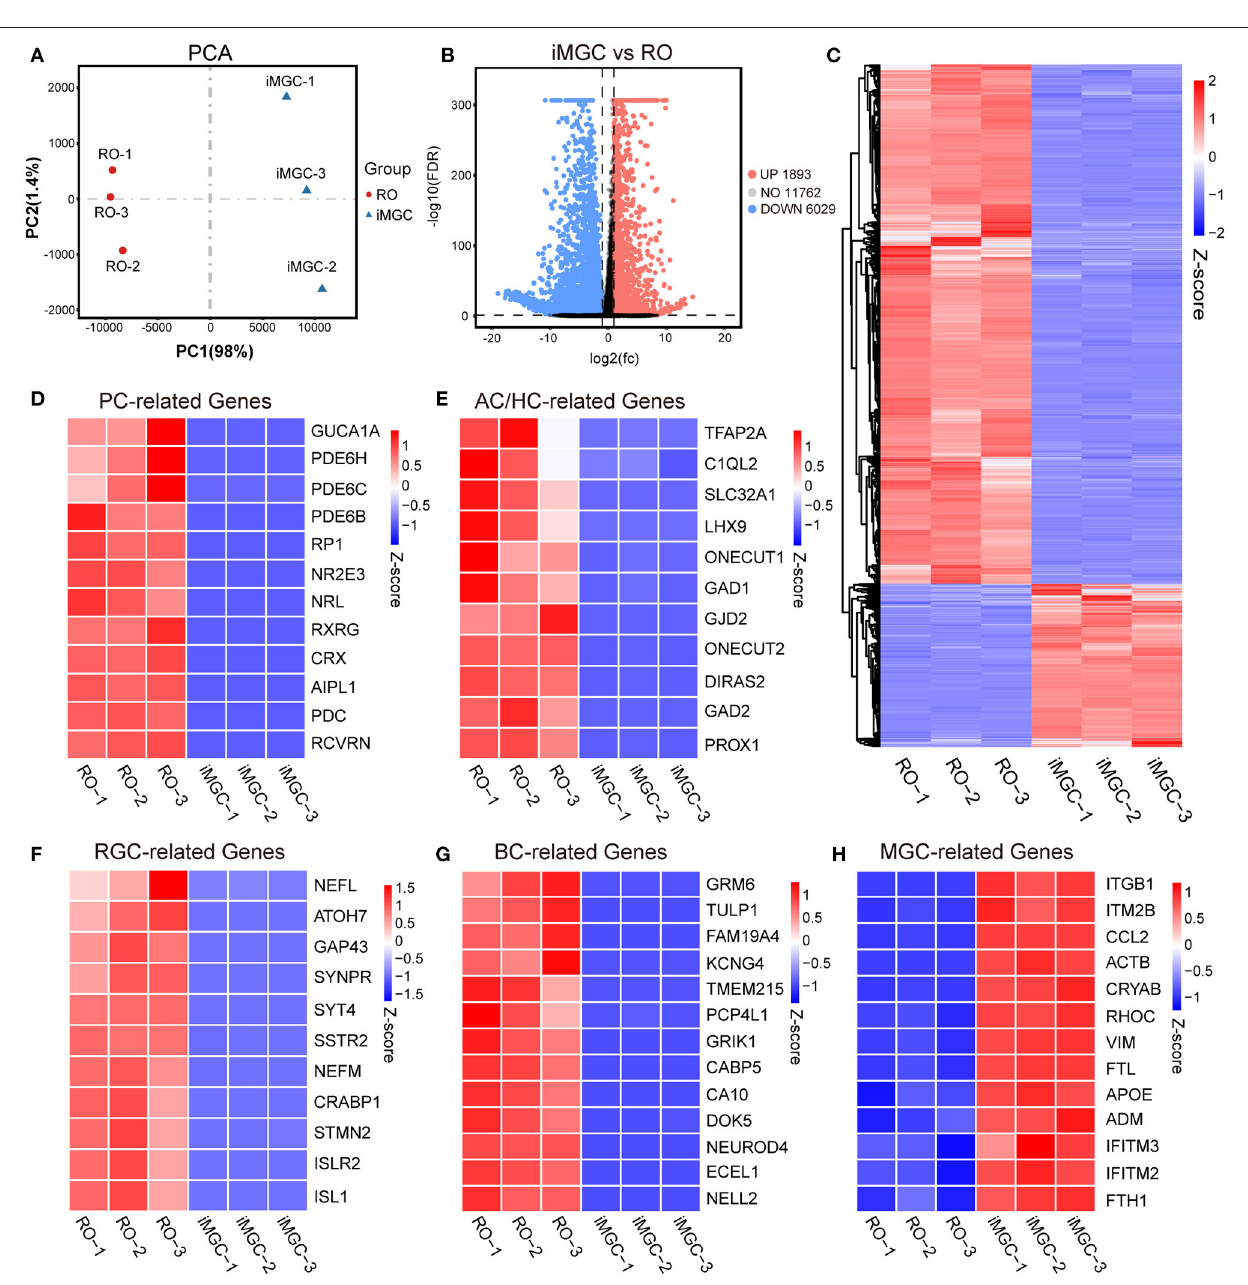
MGCs in human retina (Ohsawa and Kageyama, 2008; Kohwi and Doe, 2013; Xiang, 2013; Quinn and Wijnholds, 2019; Singh et al., 2021). Importantly, the optimal timepoint of ROs to enrich